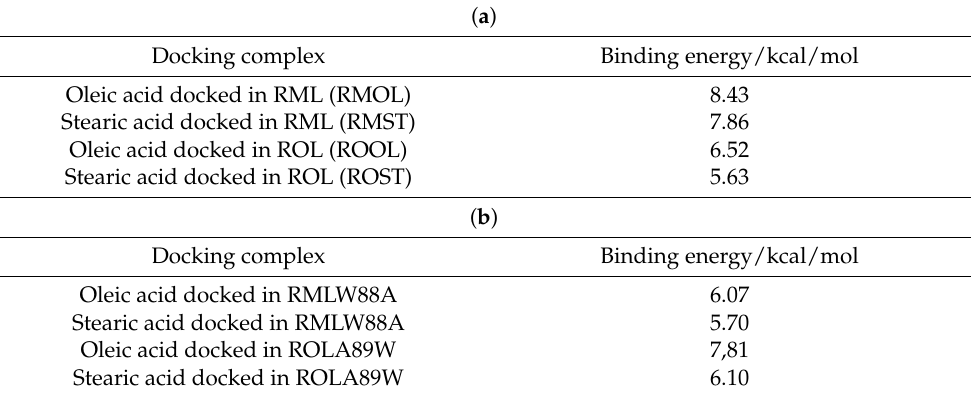
Table 2. ( a ). Binding energy of docking complexes. ( b ). Binding energy of docking